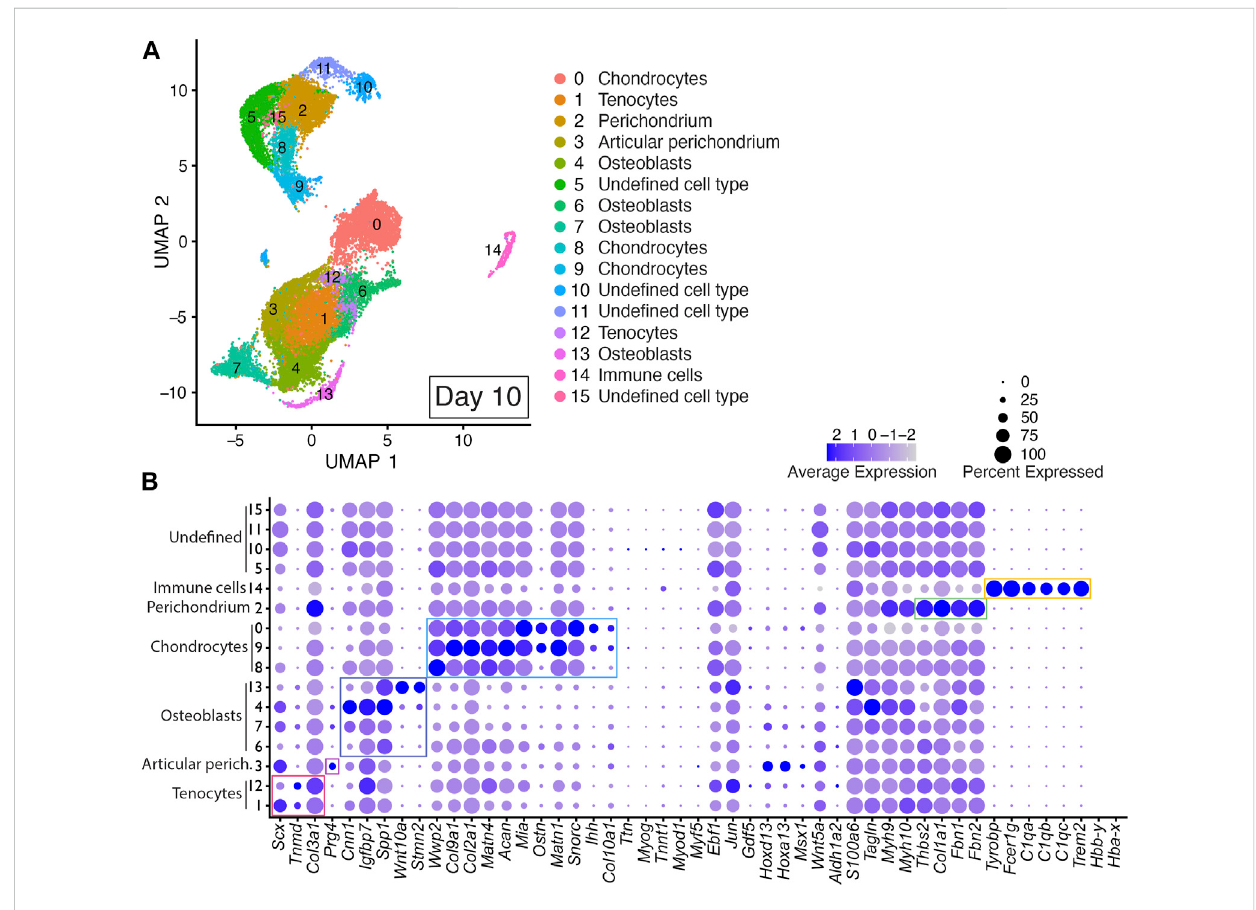
FIGURE 5 scRNAseq analysis of Day 10 in vitro cultures identi fi es multiple mature autopod cell types. (A) UMAP (Uniform Manifold Approximation and Projection) plot of Day 10 culture scRNAseq results demonstrate 16 different clusters of identi fi able cell populations. Individual cells are color coded basedonclusterandmarkergeneannotationdenotingtenocytes(Clusters1and12),articular perichondrium(Cluster3),osteoblasts(Clusters4,6,7,and 13), chondrocytes (Clusters 0, 8, and 9),articularperichondrium(Cluster 3),perichondrium (Cluster 2), immune cells (Cluster 14), and unde fi ned cell type(Clusters5,10,11,15). (B) Dotplotshighlightingexpressionpro fi lesofselectedmarkergenespercelltypeusedforclustercellidenti fi cation.Colored rectangles highlight the subset of markers used to identify tenocytes (red), articular perichondrium (pink), osteoblasts (purple), chondrocytes (blue), perichondrium (green), and immune cells (yellow). Dot diameter corresponds to the percentage of cells expressing the gene in each cluster. High-Low expression is denoted by Purple-Gray bar,